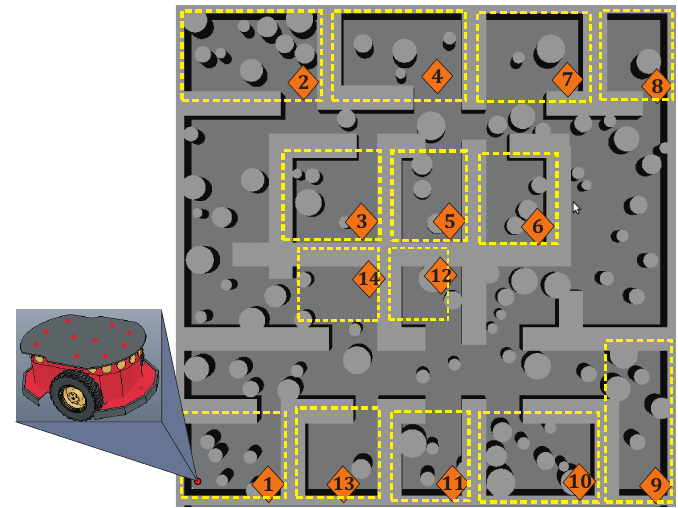
Figure 2. Multiple-target path planning issue in a complex environment (museum floor